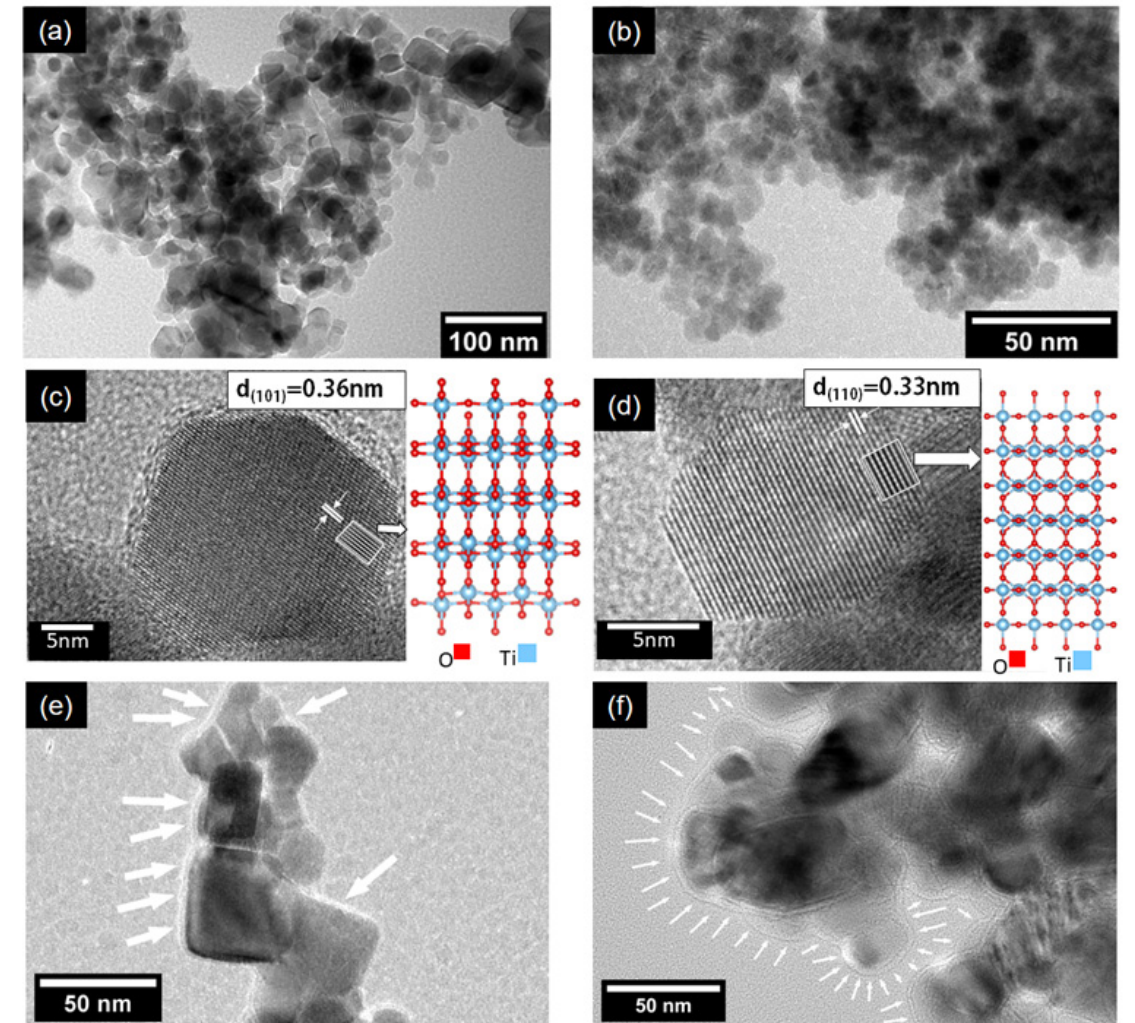
Figure 1. TEM images of the samples. P25 particle morphology at low magnification in ( a , b ). Anatase and rutile crystals in ( c , d ), respectively. Respective crystalline structure used to simulate the HRTEM images, right side of ( c , d ). Distances corresponding to the planes (101) and (110), respectively, indicated in a white box. In ( e , f ), particles of the reduced samples, BT(4.53) and BT(6.64), respectively. The layer of amorphous material observed in reduced samples is indicated with white arrows. Table 2. Anatase fraction in the samples calculated from DRX data.